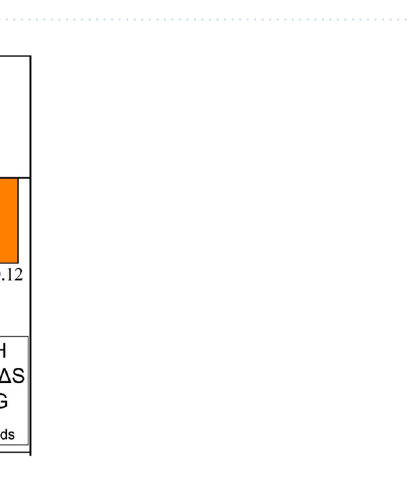
Figure 5. Close-up snapshots from interaction sites of the optimized structure of ( A ) Eg-PC, ( B ) Lu-PC, ( C ) Qu-PC, and ( D ) Re-PC complexes. Color code; C in PP: orange, C in PC: green, O: red, N: blue, P: brown, and H: white.